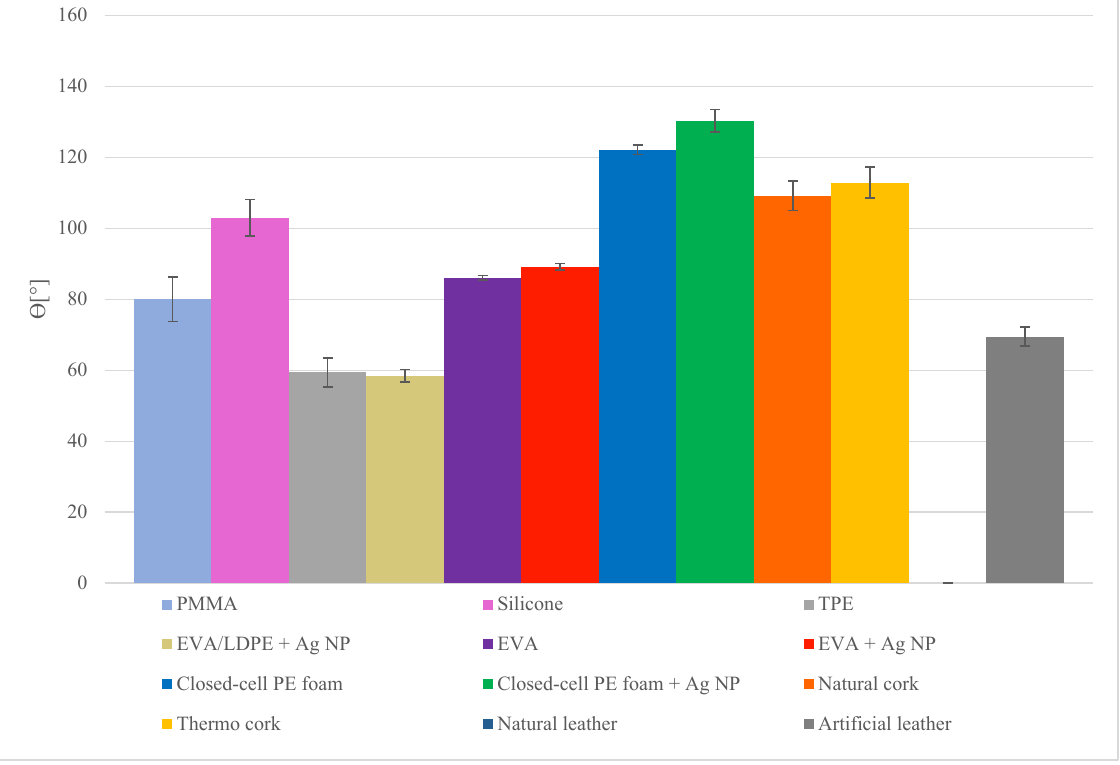
Figure 2. Water contact angles on different orthotic and prosthetic material samples measured with the tensiometer.